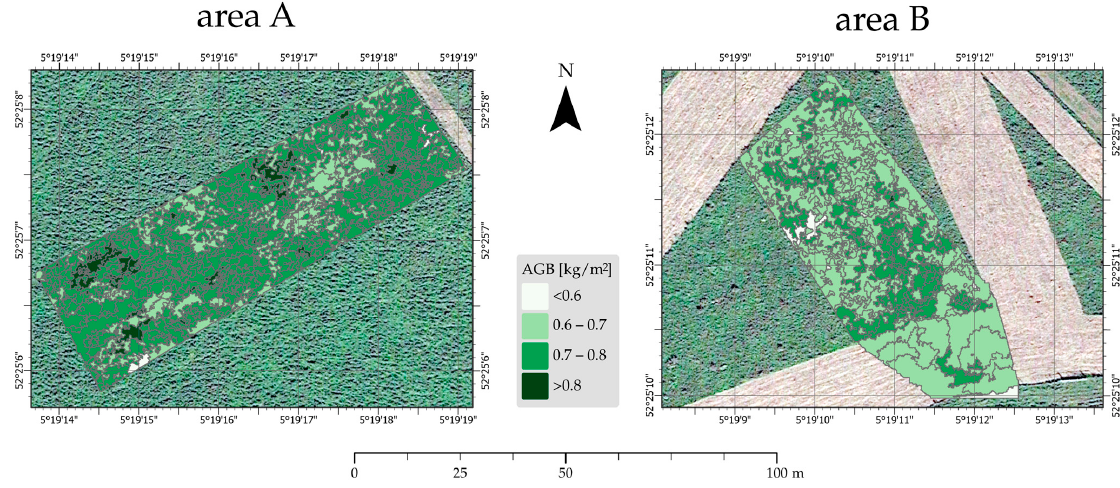
Figure 7. Segmented areas ( A ) and ( B ) with the per object variation of AGB (in kg/m 2